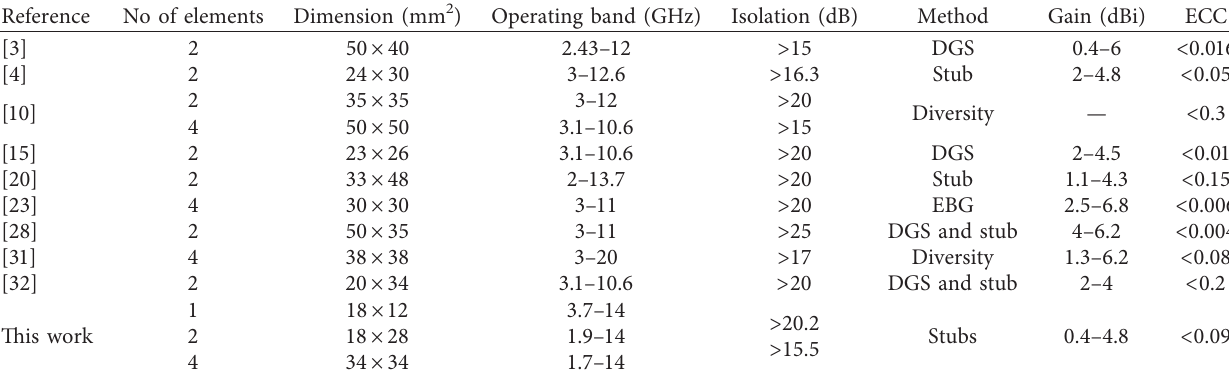
Table 1: Performance comparison of proposed antenna with other reported